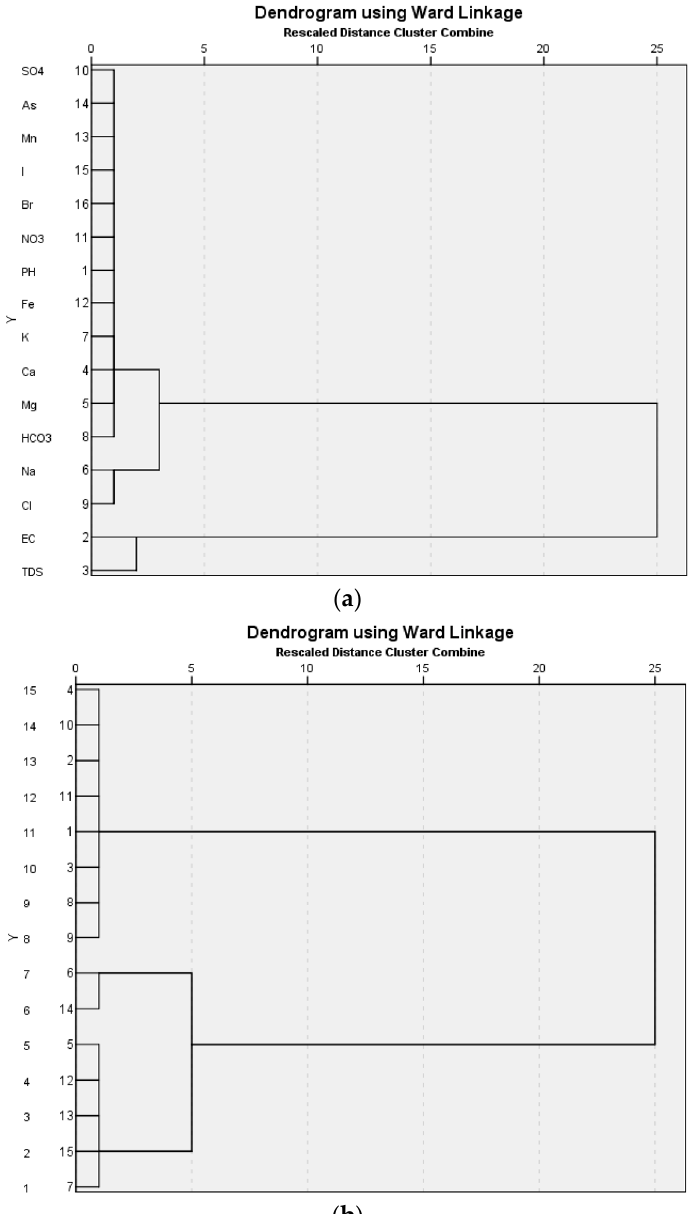
Figure 8. Dendrogram showing the clustering of samples: ( a ) R-mode cluster analysis; ( b ) Q-mode cluster